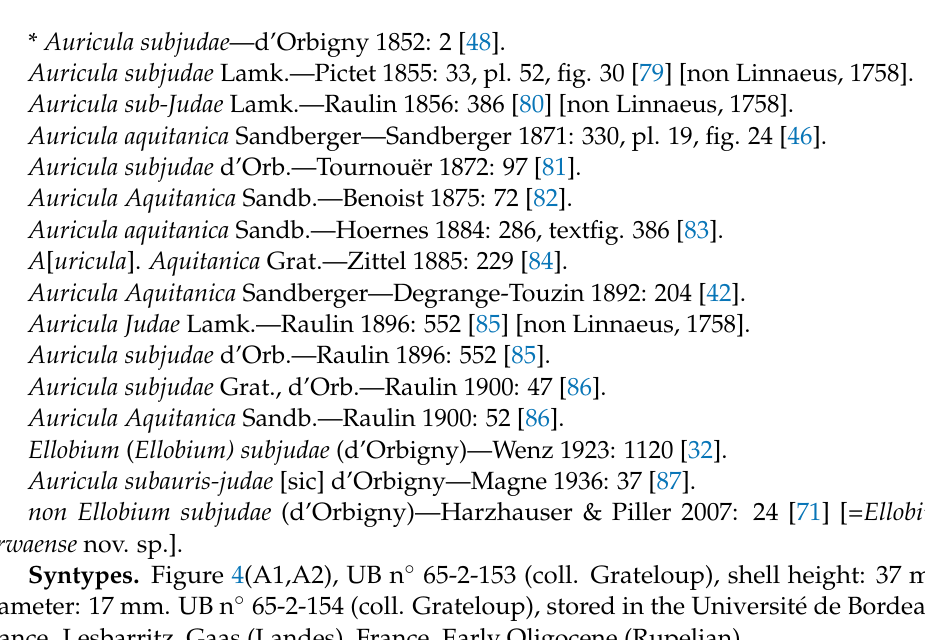
Syntypes. Figure 4(A1,A2), UB n ◦ 65-2-153 (coll. Grateloup), shell height: 37 mm, diameter: 17 mm. UB n ◦ 65-2-154 (coll. Grateloup), stored in the Universit é de